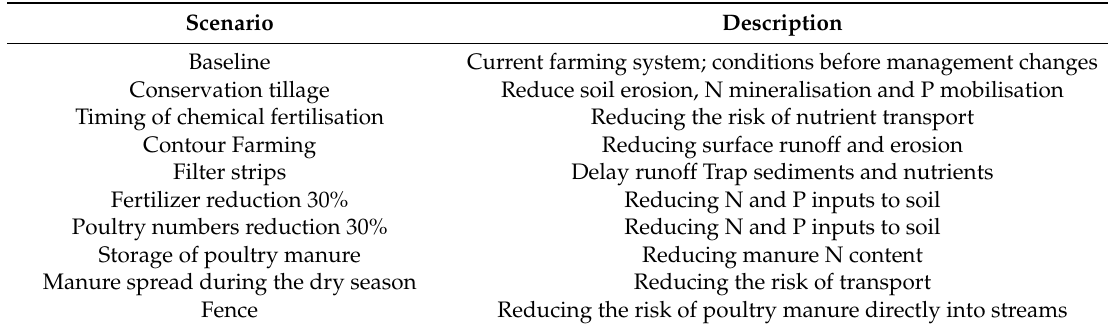
Table 1. Scenario descriptions and